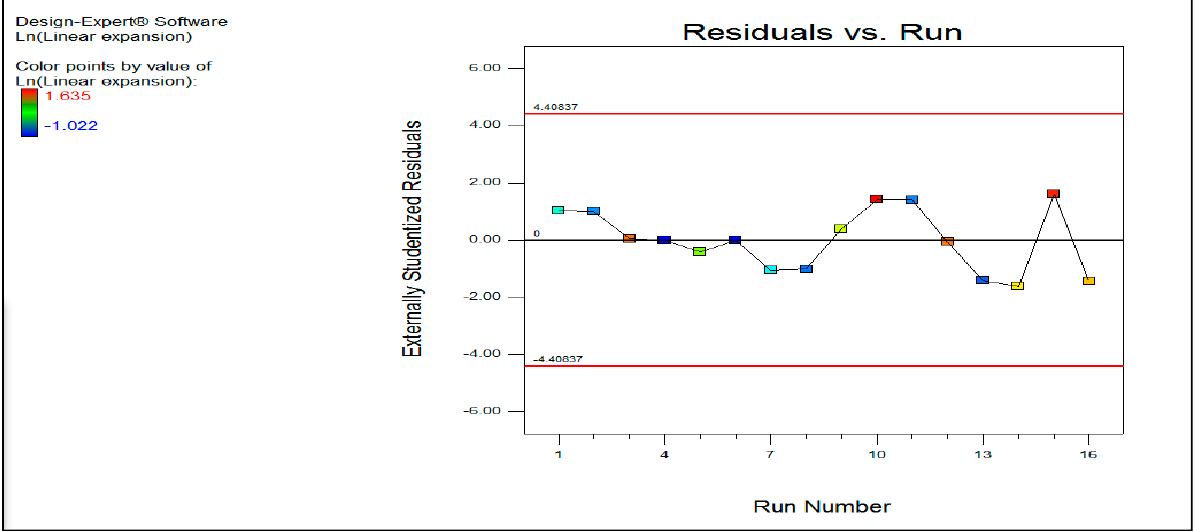
Figure 10. Residual versus experimental run.